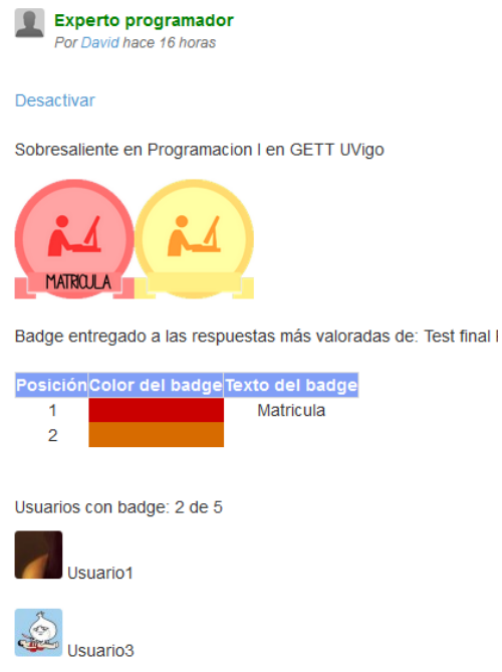
Figure 6. View of badge by contest.